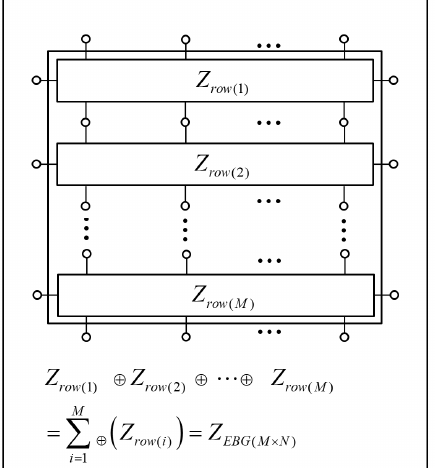
Figure 8. Iterative use of the ZRM to obtain the Z-parameter of the M × N array of the structure of the electromagnetic bandgap structure using the perforated plane technique (PP-EBG).